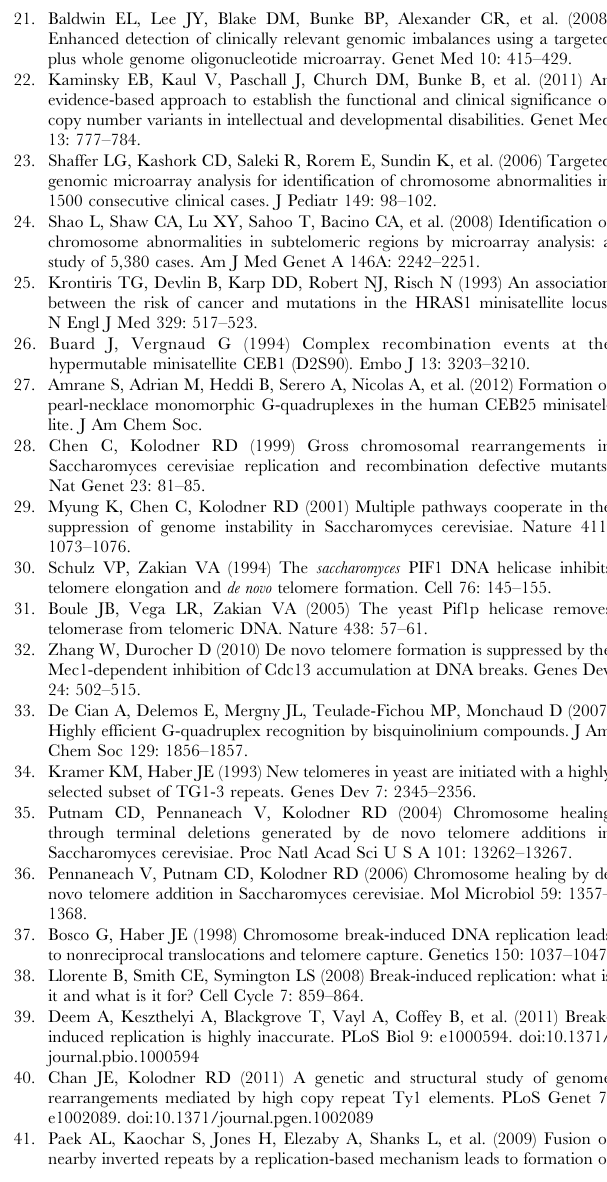
Table S5 G-quadruplex forming human minisatellites. In addition to the basic information provided in Table S4, this table give the number of non-overlapping potential G-quadruplex-forming sequenc- es for each minisatellite when searching for 4 runs of 3 Gs in a maximum of 30, 40, 50, or 100 bp sliding window (G4 , =30, G4 , =40, G4 , =50, G4 , =100, respectively)(see Materials and Methods). The number of G-quadruplexe-forming sequence per motif is also provided for the search performed with each window (last 4 lanes). The column ‘‘G4strand’’ indicates if the G-quadruplex-forming sequence was present in the Watson strand (G) or the Crick strand (C). Analyses presented in the Results section and in Figure 6 have been performed using data obtained with the most stringent search parameter (window # 30 bp). Table S6 Primers used in this study. Sequences are oriented 5 9 to 3 9